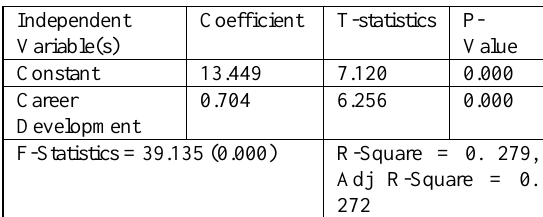
Table 3: Regression Result (Dependent variable -